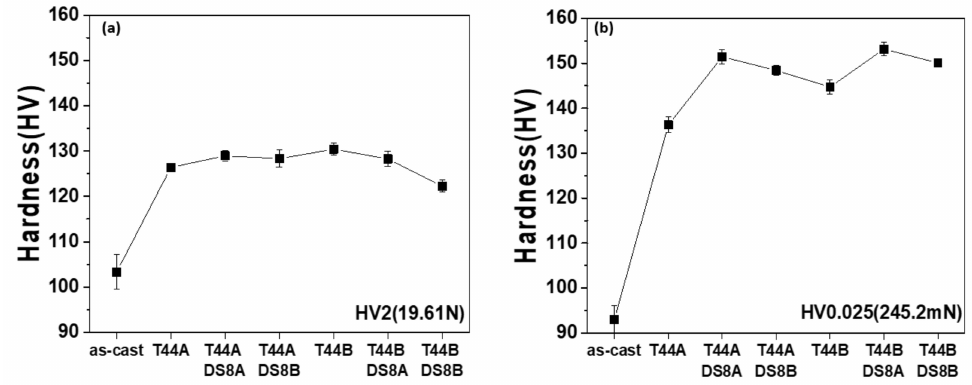
Figure 8. Micro-Vickers hardness of the alloys after various solution treatment schedules: ( a ) hardness for 2 kg load and ( b ) hardness of the Al matrix for 25 g